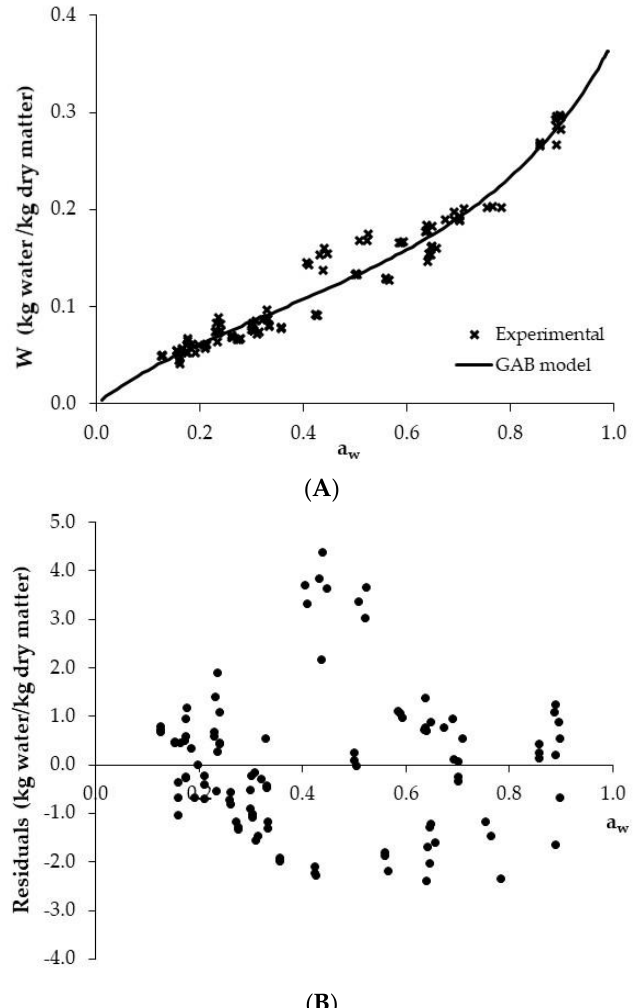
Figure 5 . Experimental puffed corn cake (PCC) adsorption isotherm and GAB model, ( A ) and distribution of residuals ( B ) .